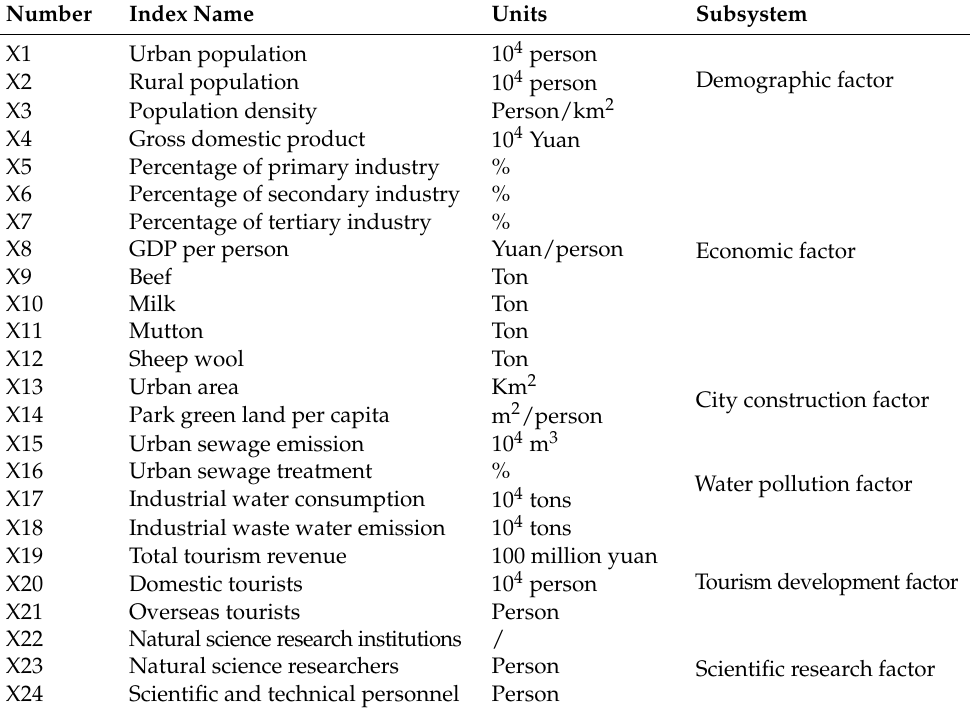
Table 1. The comprehensive evaluation index system for wetland area